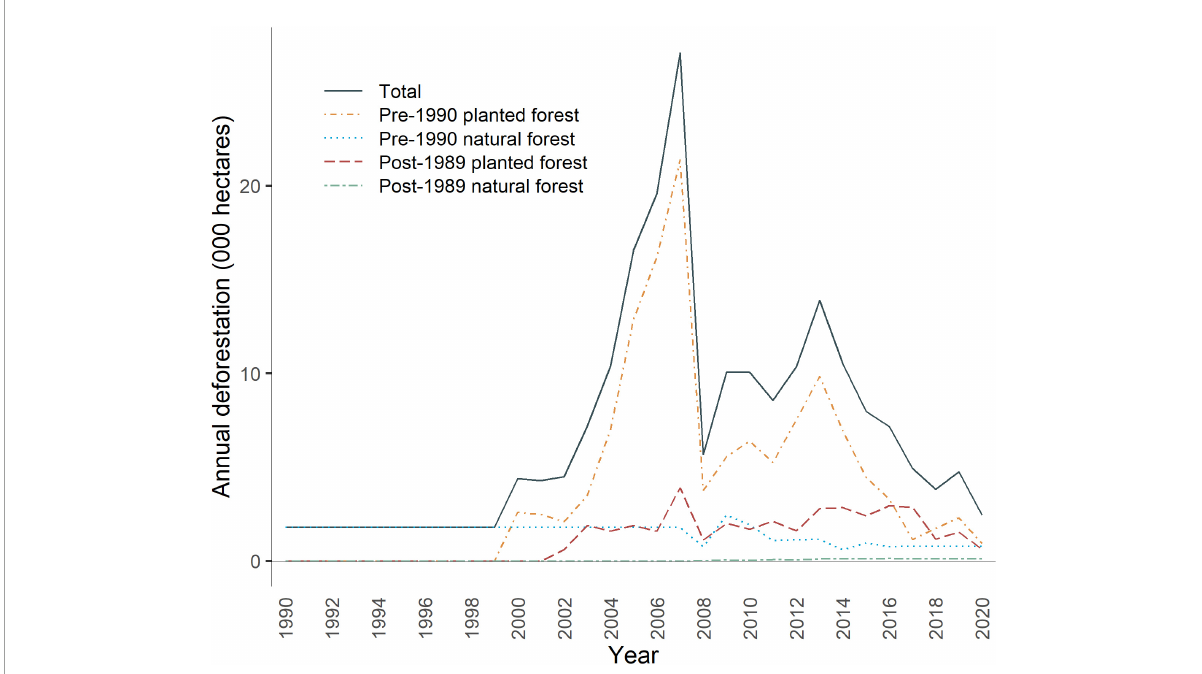
FIGURE6 Estimated annual area of observed deforestation from 1990 to 2020 by forest-land classification (pre-1990, post-1989) and forest type (natural, planted). Data from MfE (2022a).